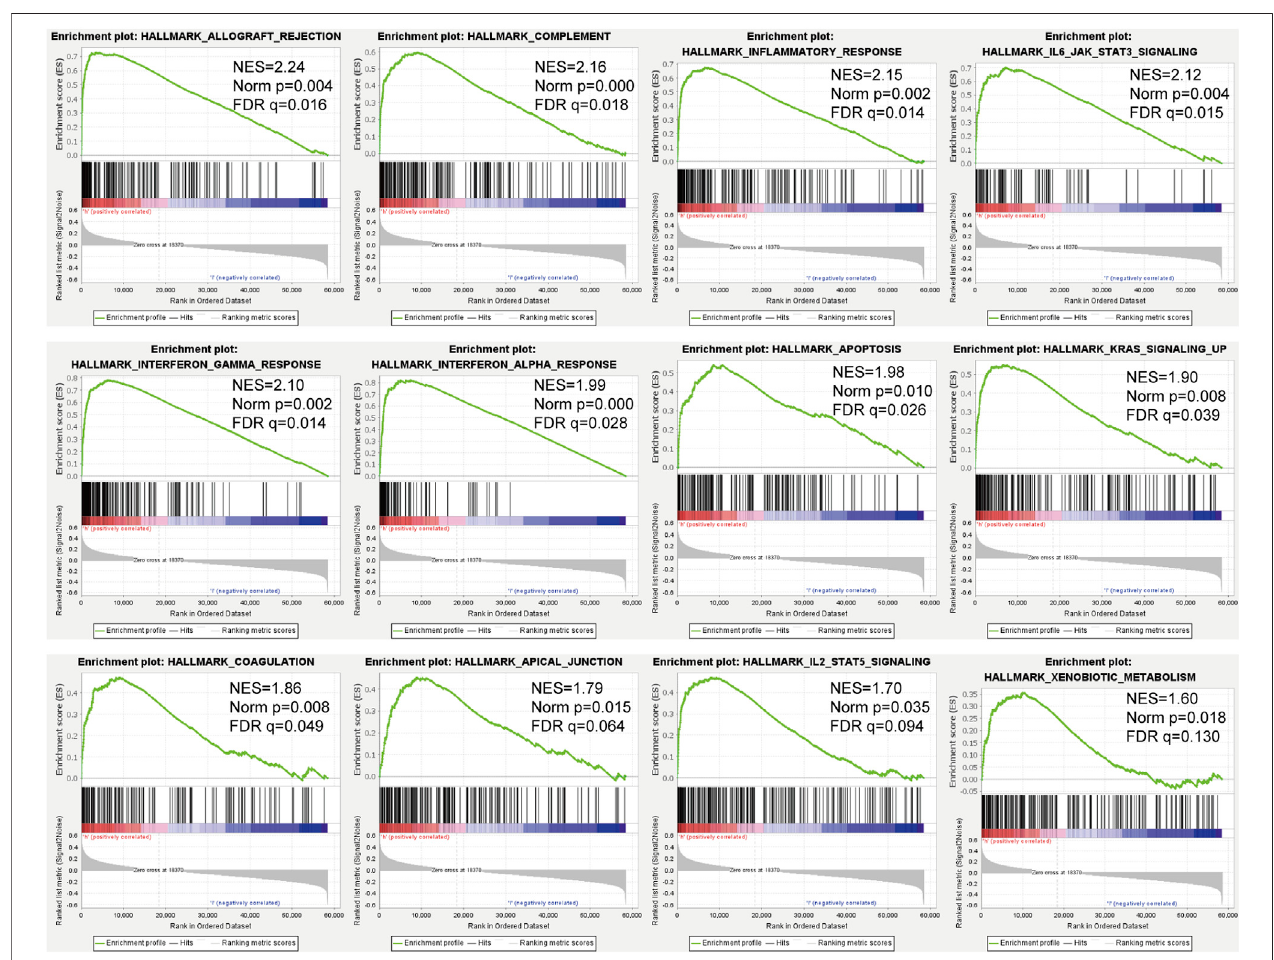
FIGURE 6 | GSEA of osteosarcoma patients based on the RBPs prognostic signature in the TARGET cohort.